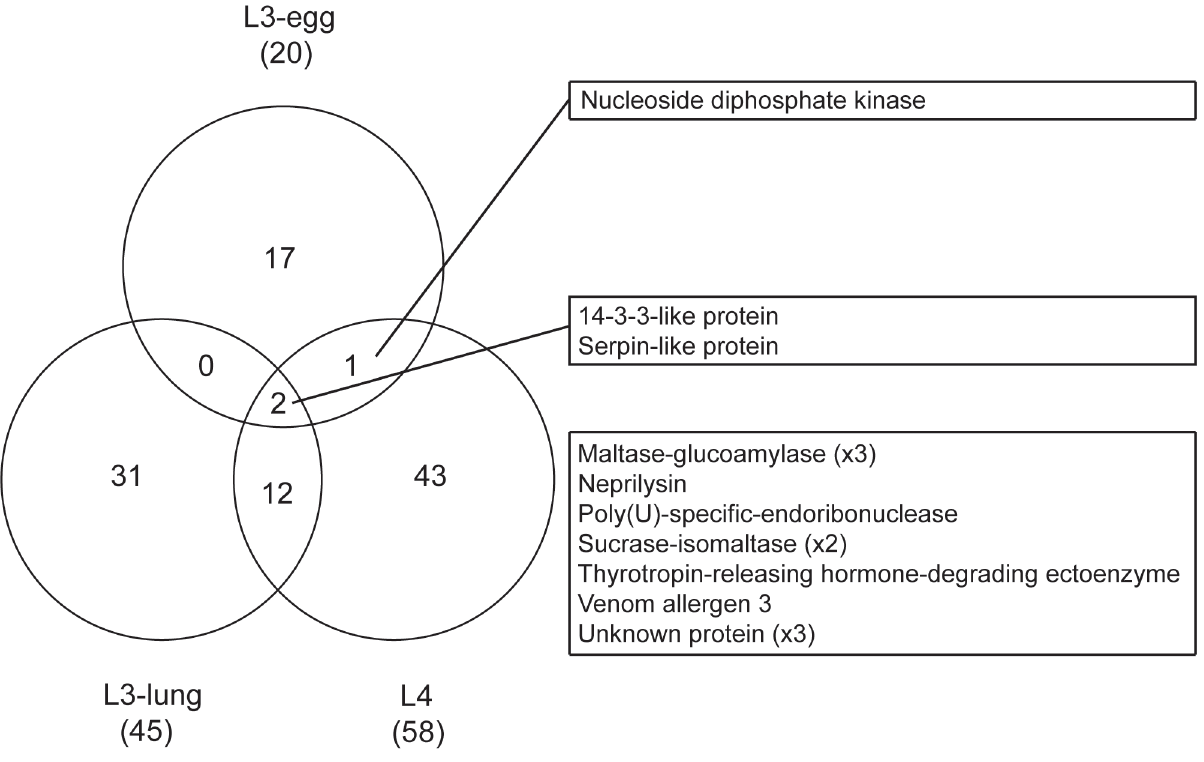
Figure 2. Venn diagram of similar proteins. Venn diagram showing the distribution of the number of proteins identified in ES products from L3- egg, L3-lung and L4 of A. suum . The proteins identified are listed on the